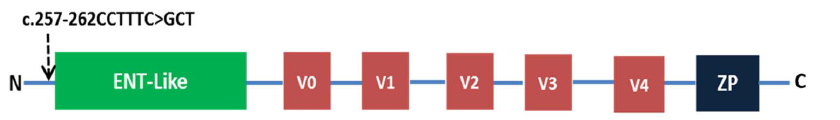
Figure 2. Domain structure of TECTA . The mutation lies within the N-terminal region, upstream from the ENT-like domain.